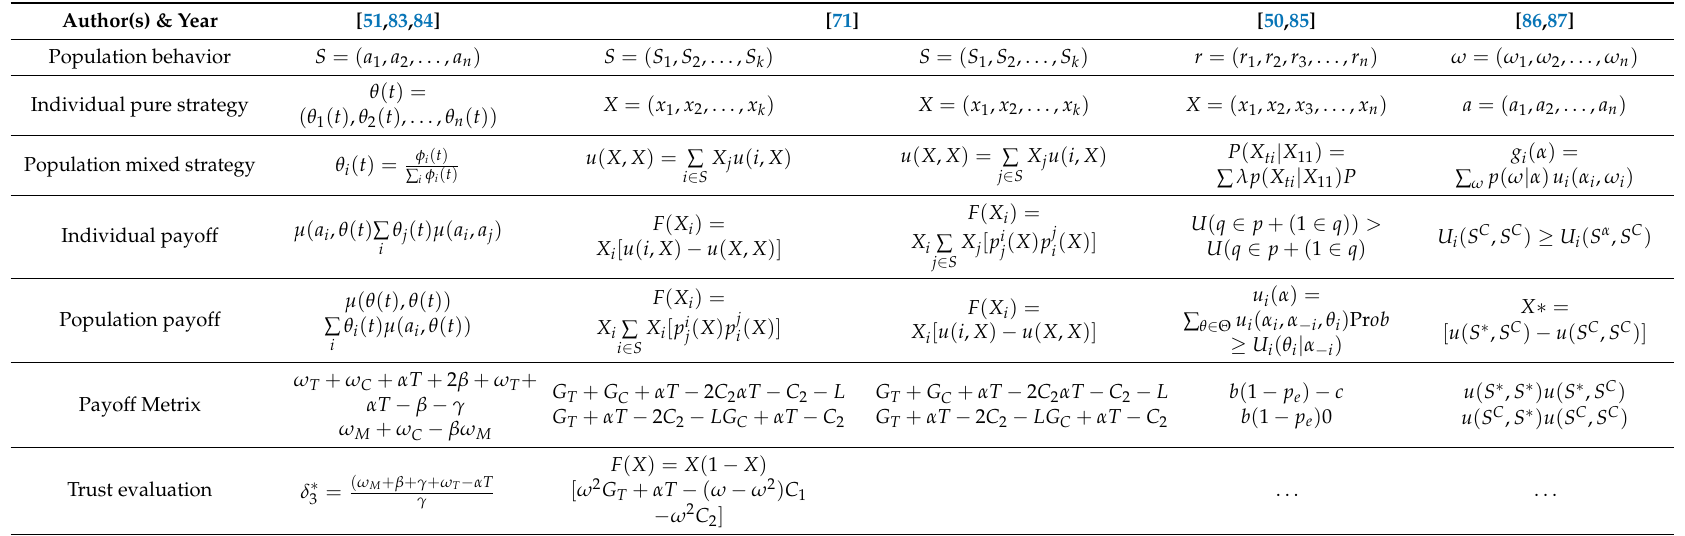
Table A4. Mathematical Comparison of Evolutionary